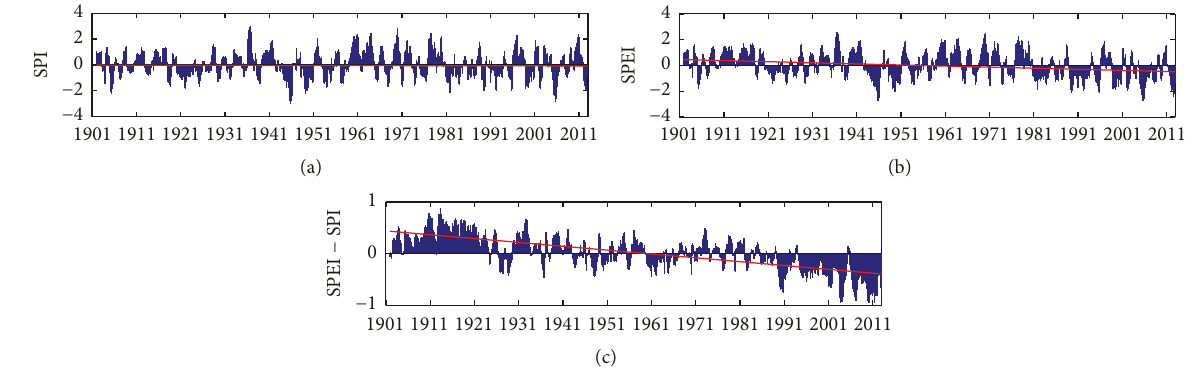
Figure 2: Average SPI (a) and SPEI (b) using Hargreaves’ method and the difference between SPEI and SPI (c) and linear trend (red line) for the Iberian Peninsula during the period 1901–2012. Table 2: As in Table 1, but for SPI, SPEI, and the difference between SPEI and SPI. The slope values shown were multiplied by 10 −3 . SPI SPEI SPEI-SPI Period Trend Slope